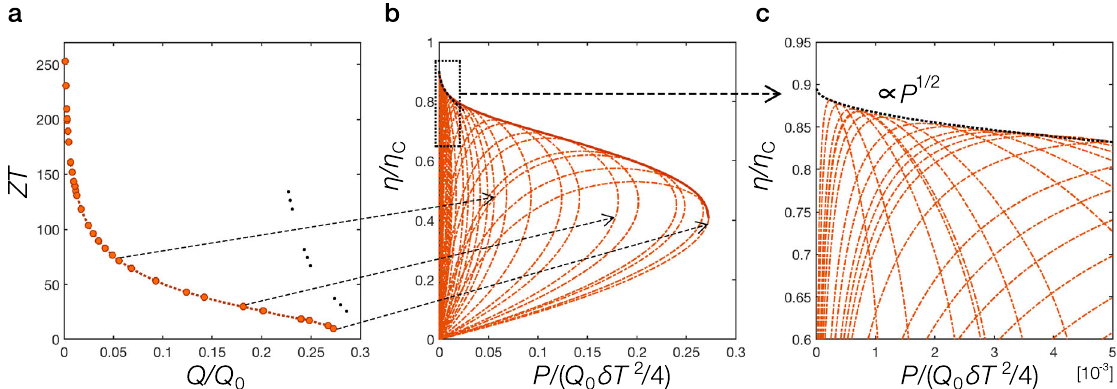
Fig. 8 Determination of the power-ef fi ciency bound in the noninteracting machines. a The Pareto-optimal values of ( Q , ZT ) pairs are determined from the multiobjective optimization. b For each pair of the optimal solutions of ( Q , ZT ) plotted in a , the lasso-type power-ef fi ciency curve (red dotted curve) is drawn as indicated by the black dotted arrow. c Magni fi ed plot of the power-ef fi ciency bound at the low power output. Black dotted line indicates the envelope curve of the power-ef fi ciency loops (red dotted curves), which agrees with the square-root scaling / number of single-electron levels N f = 9 and generic (nondegenerate) single-electron levels. We set ϵ l = l Δ with Δ / k B T = 3, γ h = γ c ≡ γ , and plot Q in the unit of Q 0 = k B γ / T . The ef fi ciency and power factor are normalized by η C and Q